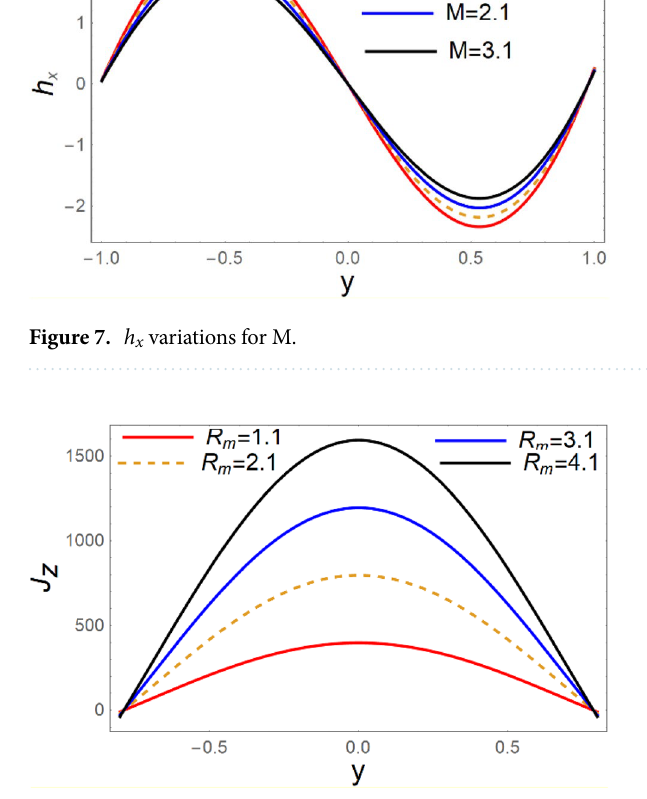
Figure 8. J z variations for R m .